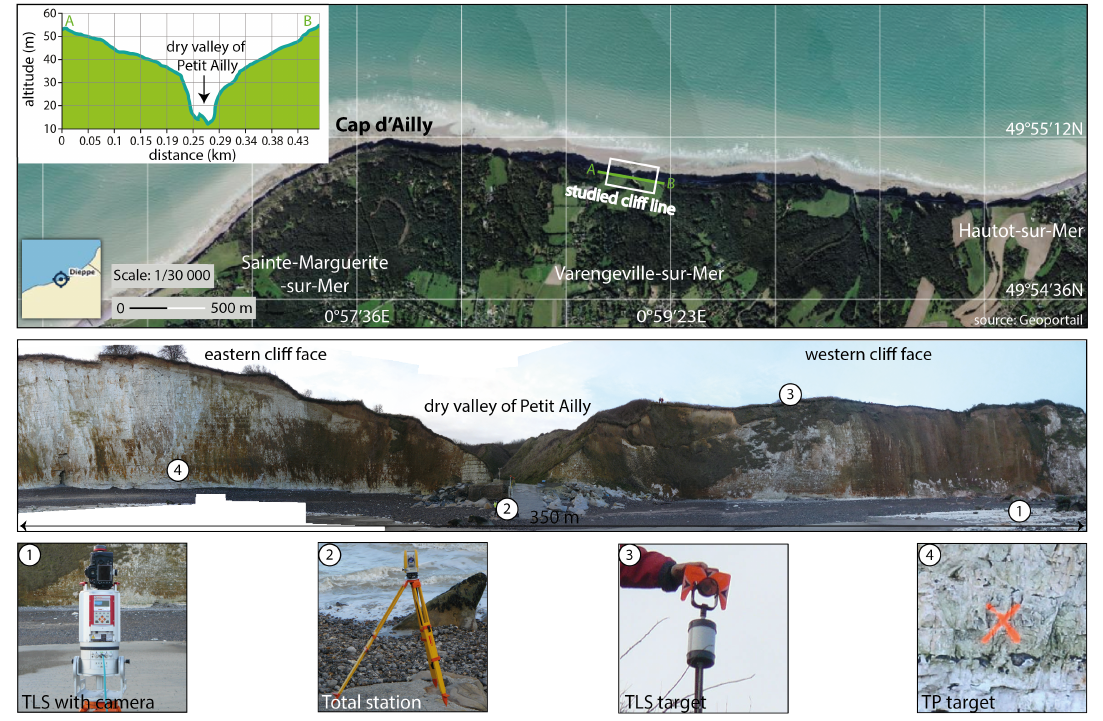
Figure 1. Panorama and aerial photography of Petit Ailly cliff (Varengeville-sur-Mer) and instrumentation used for the TLS survey (2016-01-28) (modified from Letortu et al. (2018)).